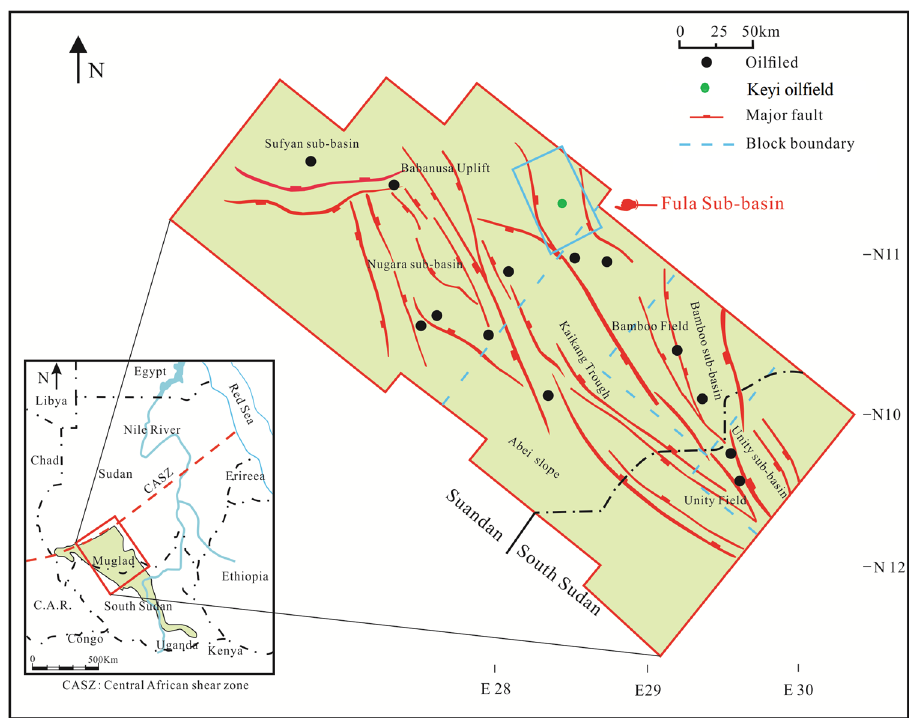
Figure 1. Location of map showing the Keyi oilfield, Northeastern region of the Muglad Basin, Sudan. It also shows the main oilfields discovered, major fault and block boundary (created using CorelDRAW Graphics Suite 2018 v20.0.0.633 https ://www.corel